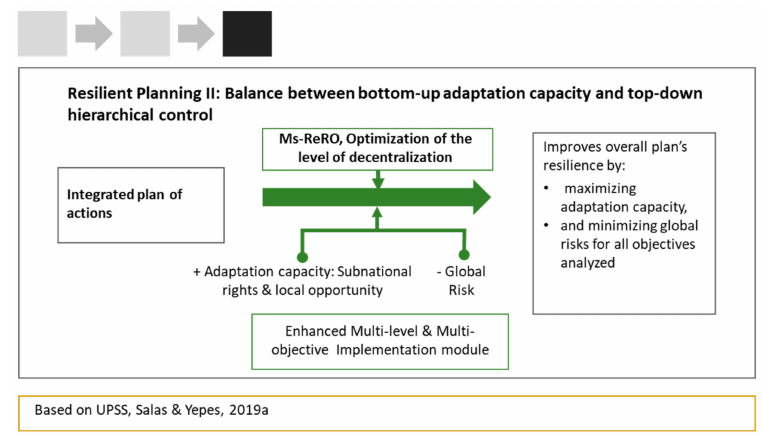
Figure 4. Step 3: implementation planning and risk